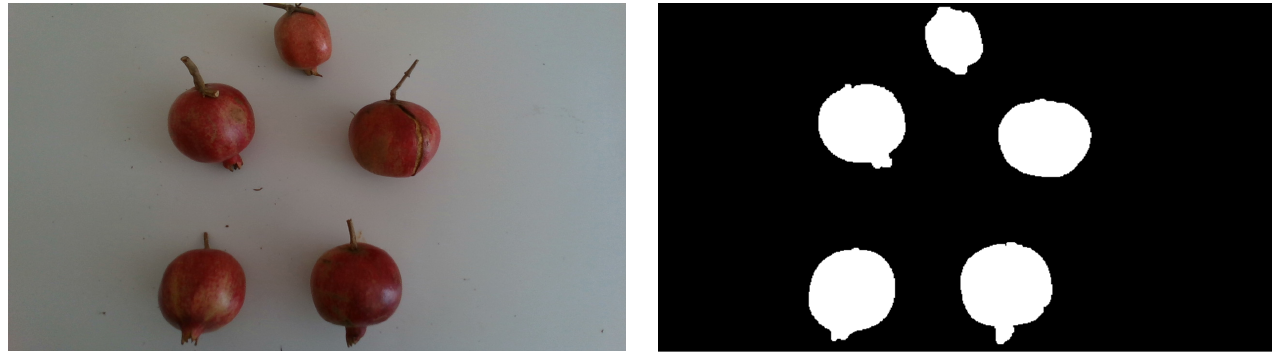
Figure 5. Sample image from SET1 ( left ) and the corresponding labeled image obtained by color threshold and morphological operations ( right ).